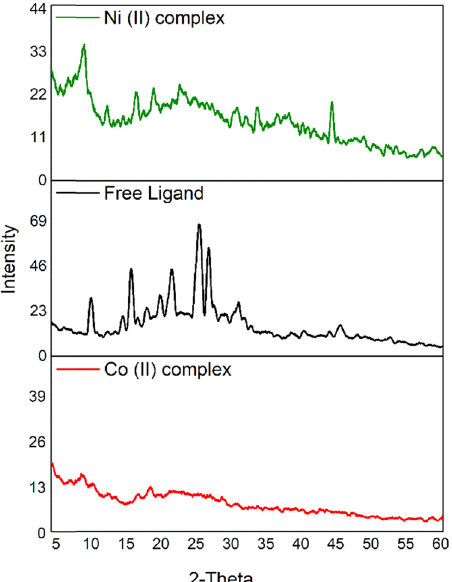
Figure 7: PXRD pattern of the free ligand, Co ( II ) and Ni ( II )